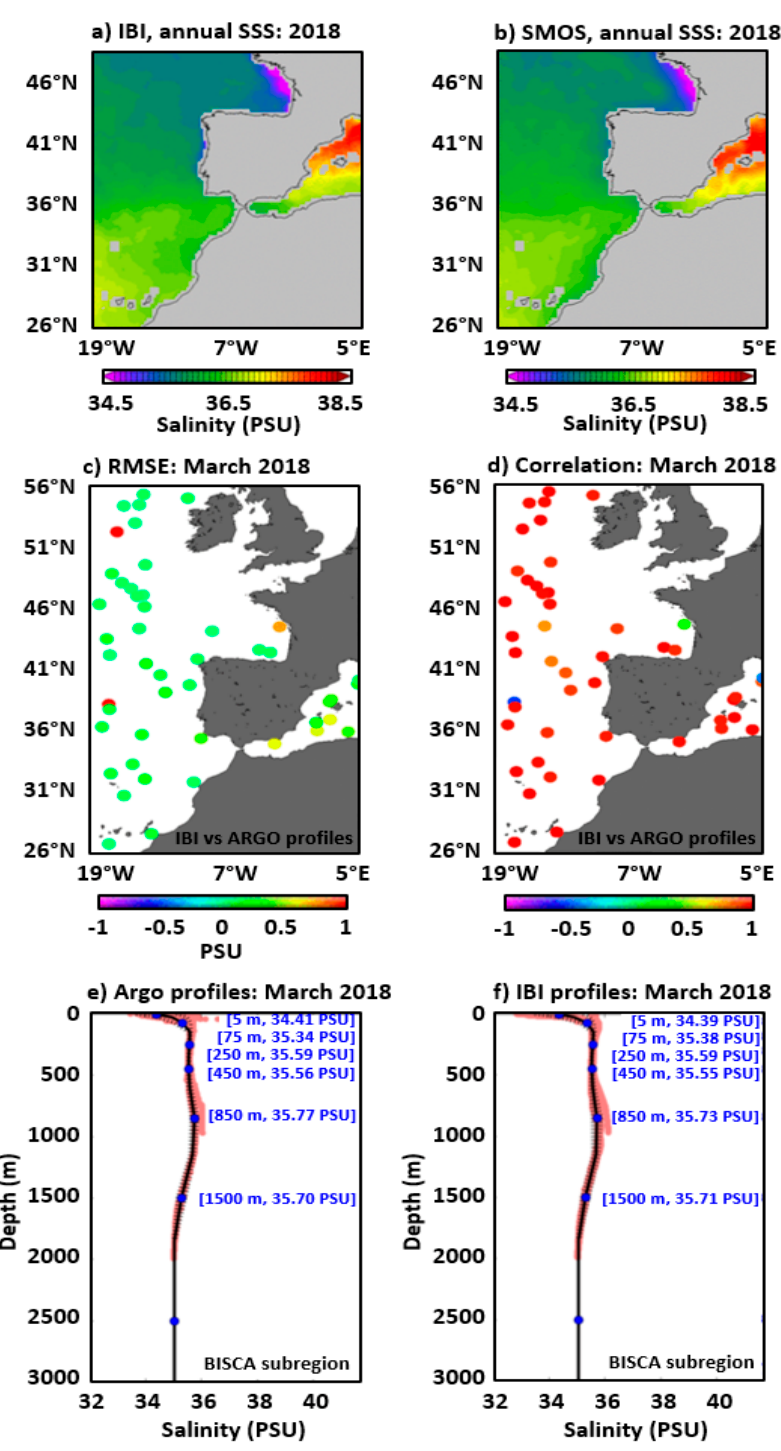
Figure 4. 2018 yearly averaged maps of sea surface salinity (SSS) simulated by CMEMS IBI ( a ) and derived from remotely sensed SMOS data ( b ). Monthly maps (March 2018) of skill metrics derived from the comparison of entire salinity profiles observed by Argo floats and modelled by CMEMS IBI: root mean squared error ( c ) and correlation ( d ). Daily salinity profiles collected by Argo floats ( e ) and IBI ( f ) in the Gulf of Biscay (BISCA zone) during March 2018. Averaged profiles exposed in solid black lines. Mean depth values gathered in blue.